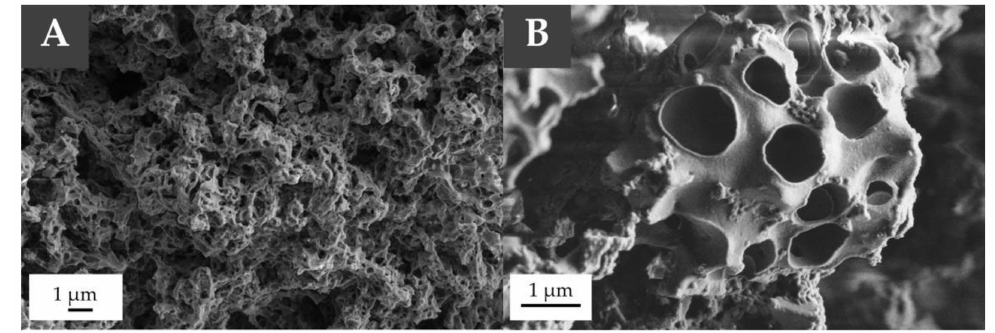
Figure 3. SEM pictures of a representative freeze-dried G1-polyHIPE crosslinked with 50 µ l of GLU,